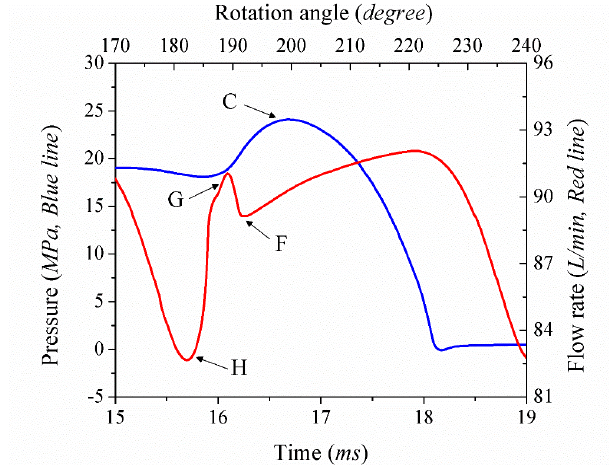
Figure 7. Simulation variations in the pressure and flow